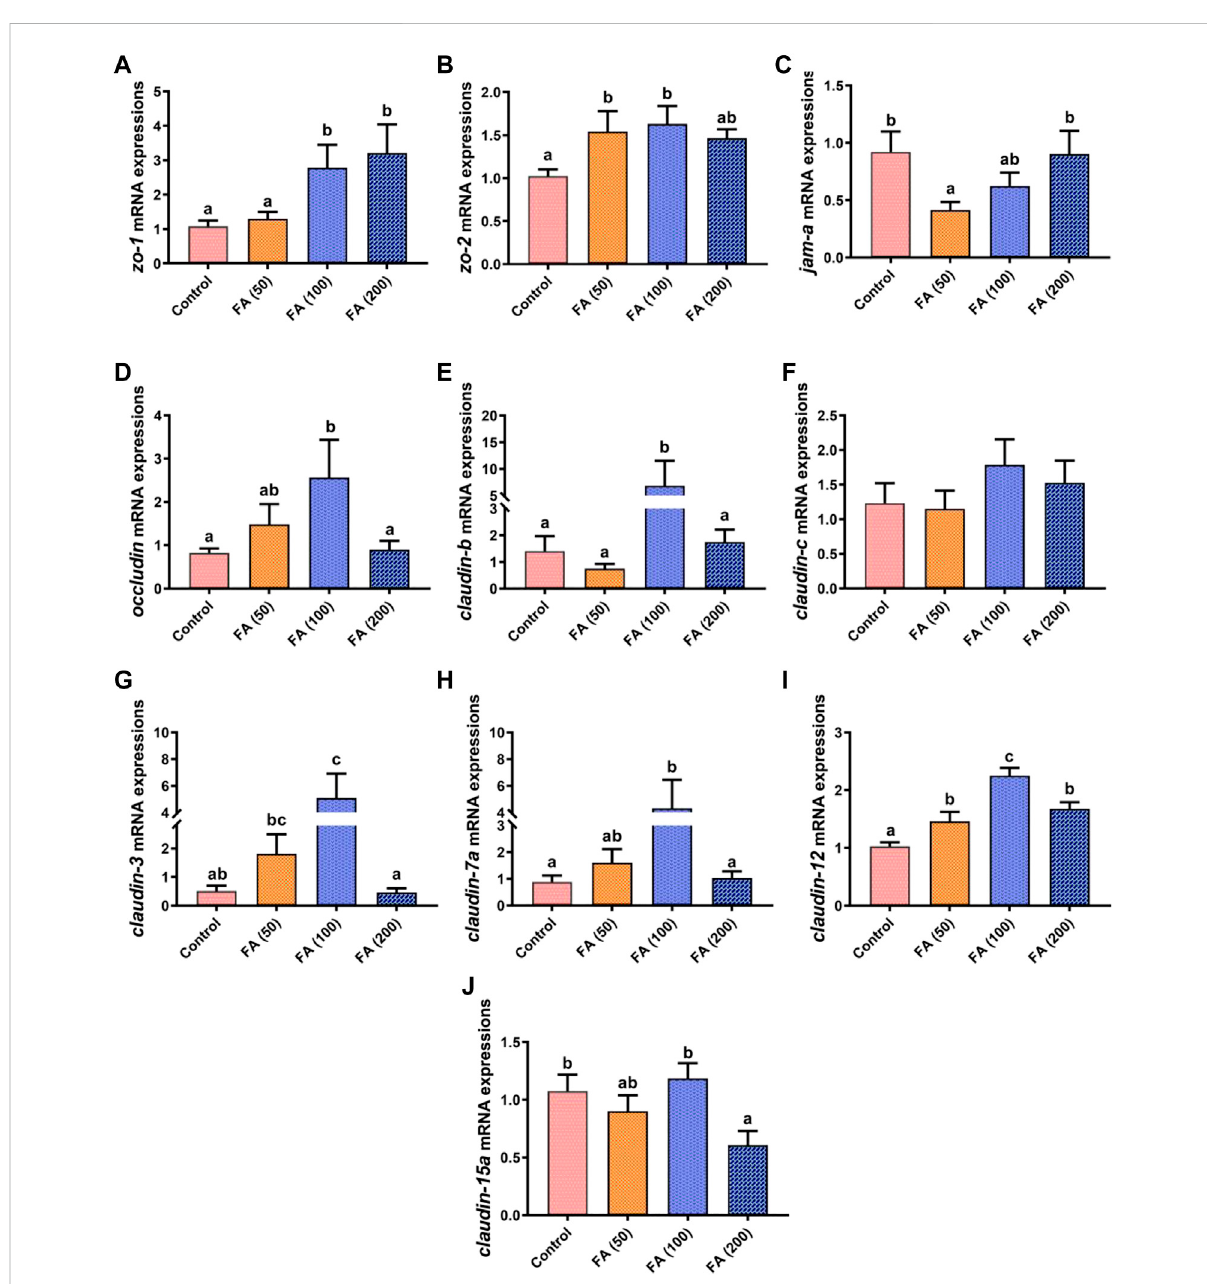
FIGURE 5 Relative mRNA expression of tight junction protein genes the zonula occludens-1 gene ( zo-1 ; (A) , zo-2 (B) , junctional adhesion molecule-A ( jam-a ; (C) , occludin (D) , claudin-b (E) , claudin-c (F) , claudin-3 (G) , claudin-7a (H) , claudin-12 (I) , and claudin-15a (J) intheintestine ofjuvenilegrass carp fed CSM-based diets containing graded levels of ferulic acid. Control: high CSM diet; FA (50): high CSM diet +50 mg/kg ferulic acid; FA (100): highCSMdiet+100 mg/kgferulicacid;FA(200):highCSMdiet+200 mg/kgferulicacid.Theresultsareexpressedasmeans±standarderrorof the means ( n = 9). Means of the same parameter with different superscripts are signi fi cantly different ( p <